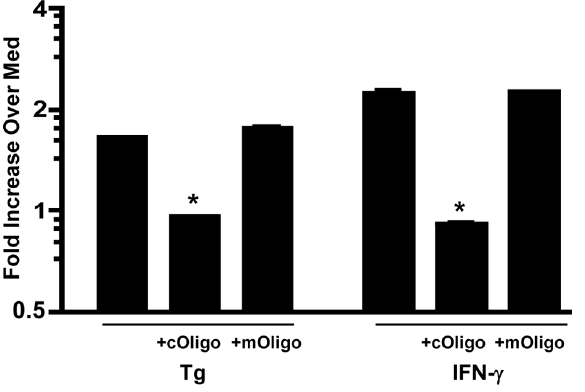
Figure 3. Toxoplasma induces invitro STAT1 binding activity in BMDC. Nuclear extracts were prepared from cells infected with the RH parasite strain (Tg, Toxoplasma gondii ; 3:1 parasites to cells) or treated with IFN c (100 ng/ml) for 6 hours. The in vitro binding activity of nuclear STAT1 to solid phase IFN c -activated sequence (GAS) oligonu- cleotides was assessed using an ELISA-based method. Binding activity is expressed as fold increase over cells cultured in medium alone (Med, value of 1). + cOligo, addition of soluble competitive oligonucleotides; + mOligo, addition of mutated non-competitive oligonucleotides. The experiment was repeated three times with similar results. *, p , 0.05 comparing nuclear extracts alone with nuclear extracts plus cOligo.